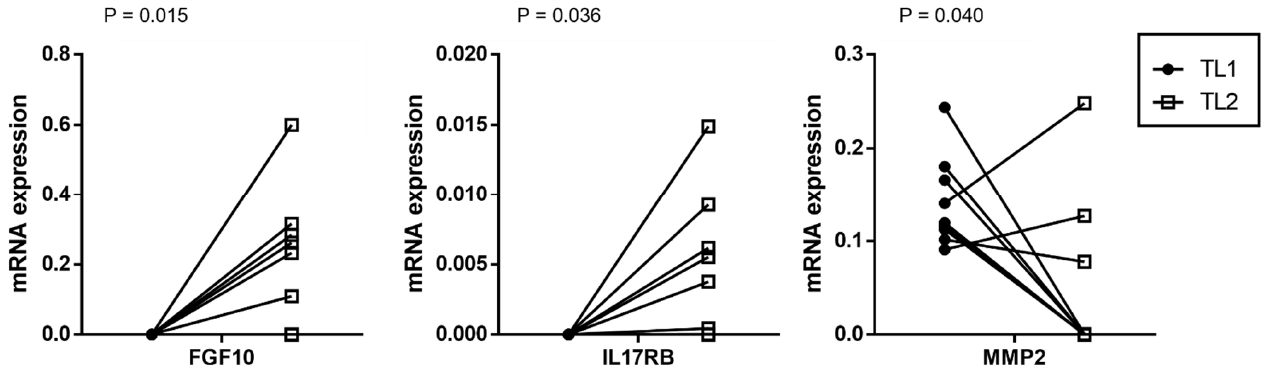
Figure 3. Gene expression of stromal factors by CAFs from two foci of nine multifocal prostate car ‐ cinomas: main tumor location (TL1) and secondary tumor focus (TL2).